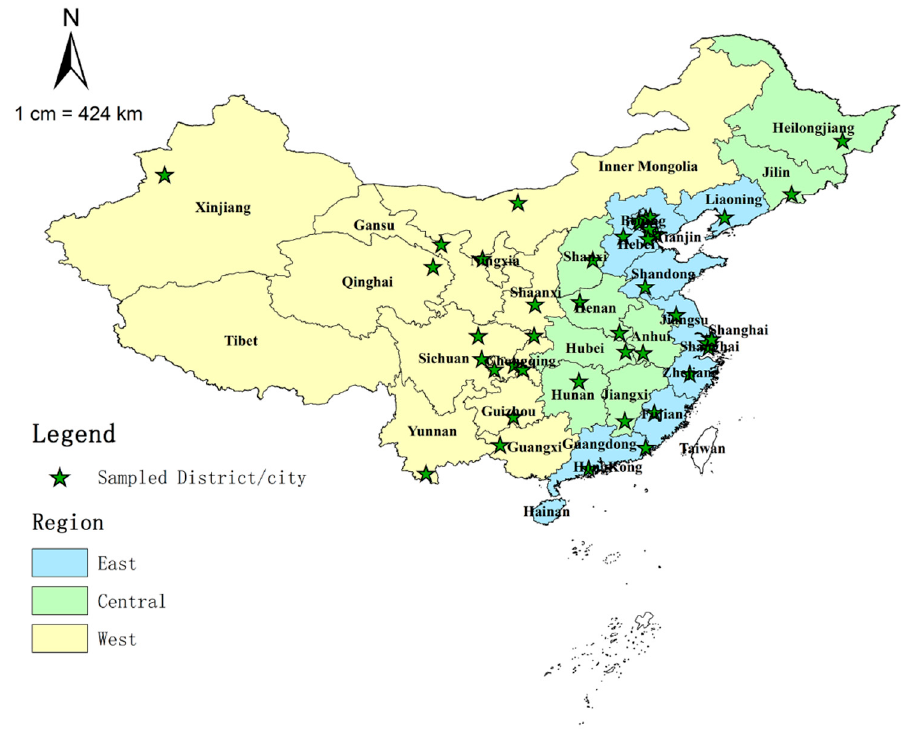
Figure 1. Map of China showing the East, Central, and West regions and sampled districts/cities.